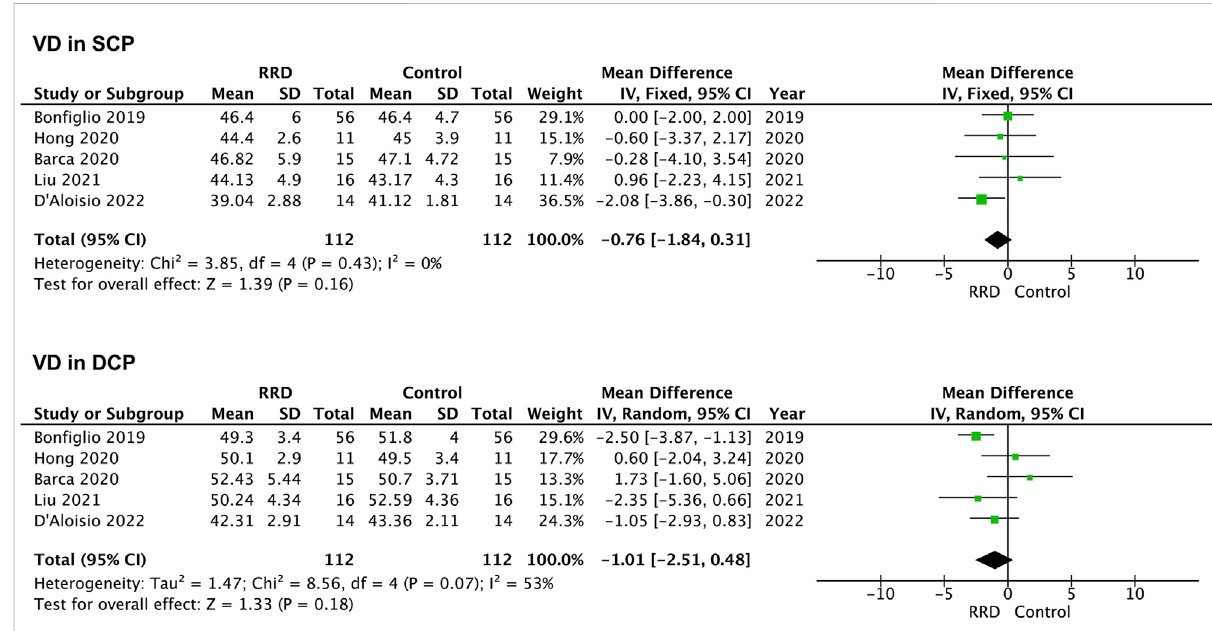
FIGURE 6 ForestplotsofchangesinparafovealVDineyeswithMacula-on RRD.VD,vasculardensity,SCP,super fi cialcapillary plexus; DCP,deepcapillary plexus, RRD, rhegmatogenous retinal detachment.